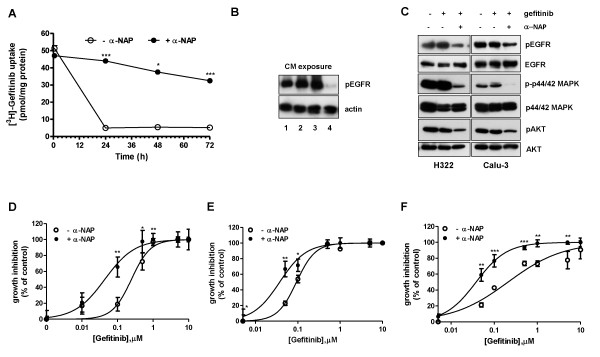
Effects of CYP1A1 inhibition on intracellular level of gefitinib, EGFR autophosphorylation and inhibition of cell growth. A) Calu-3 cells were incubated with 0.1 μM [3H]gefitinib for 0.5, 24, 48 or 72 h in the absence or in the presence of 10 μM α-NAP. Values given of gefitinib content, expressed as pmol/mg of protein, are the means (± SD) of four independent determinations. α-NAP was renewed after 36 h of gefitinib treatment. (***P < 0.001). B) Calu-3 cells were treated with 0.1 μM gefitinib for 24 h in the absence or in the presence of 10 μM α-NAP, then the conditioned media (CM) were collected and extracts were prepared from H322 cells exposed for 2 h to CM. The effect of CM on EGF (0.1 μg/ml for 5 min)-induced EGFR autophosphorylation was examined by Western blotting using monoclonal antibodies directed against pEGFR(Tyr1068) and actin. The experiment, repeated twice, yielded similar results. Line 1: CM from control cells; line 2: CM from gefitinib treated cells; line 3: CM from α-NAP treated cells; line 4: CM from α-NAP and gefitinib treated cells. C) H322 and Calu-3 cells were incubated for 48 h with 0.1 μM gefitinib in the absence or in the presence of 10 μM α-NAP. Before protein extraction cells were stimulated with 0.1 μg/ml EGF for 5 min. Western blot analysis was performed by using monoclonal antibodies directed against pEGFR(Tyr1068), EGFR, p-p44/42 MAPK, p44/42 MAPK, pAKT (Ser473), AKT. The experiment, repeated three times, yielded similar results. α-NAP was renewed after 24 h of gefitinib treatment. D) Calu-3, (E) H322, (F) H292 were exposed for 72 h to different concentrations of gefitinib in the absence or in the presence of 10 μM α-NAP. Cell growth was assessed using crystal violet staining as described in Materials and Methods. Data are expressed as percent inhibition of cell proliferation versus control cells. The mean values of three independent measurements (± SD) are shown. α-NAP was renewed after 36 h of gefitinib treatment (*P < 0.05; **P < 0.01; ***P < 0.001).